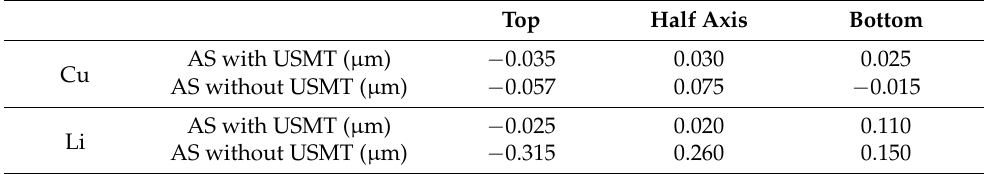
Table 4. Macro-segregation ( ∆ C ) of Cu and Li at representative positions. Top Half Axis Bottom AS with USMT ( µ m) − 0.035 0.030 0.025 Cu AS without USMT ( µ m) − 0.057 0.075 − 0.015 AS with USMT ( µ m) − 0.025 Li